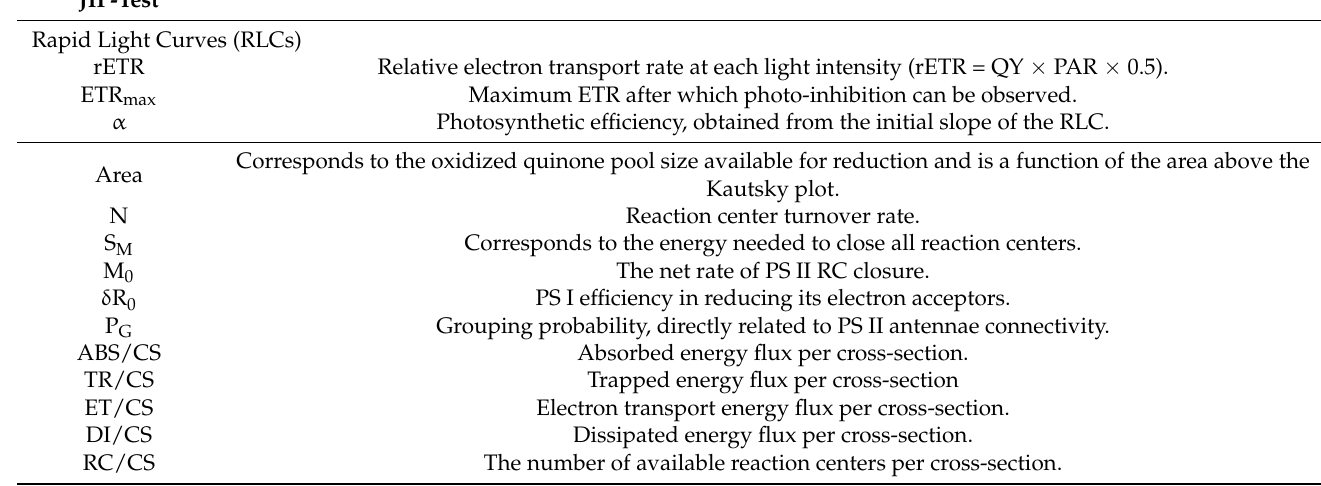
Table 2. Summary of fluorometric analysis parameters and their